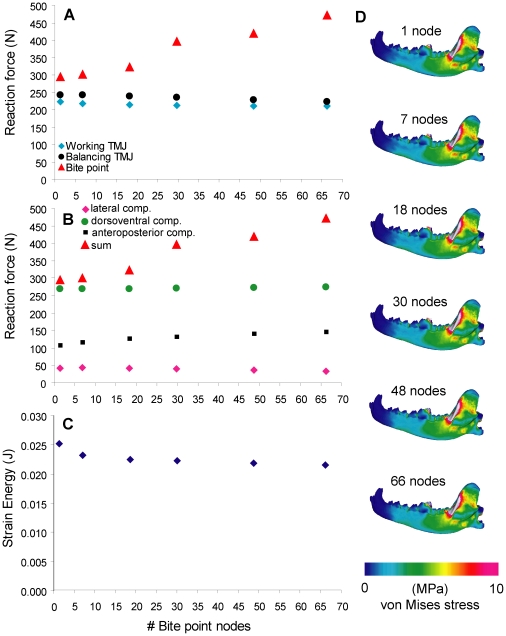
Sensitivity test on nodes at the bite point constraint.
A. Nodal constraints plotted against reaction force. B. Nodal constraints plotted against reaction force, showing components of the bite force vector. C. Nodal constraints plotted against strain energy. D. von Mises stress distribution in the working-side dentary in test models.